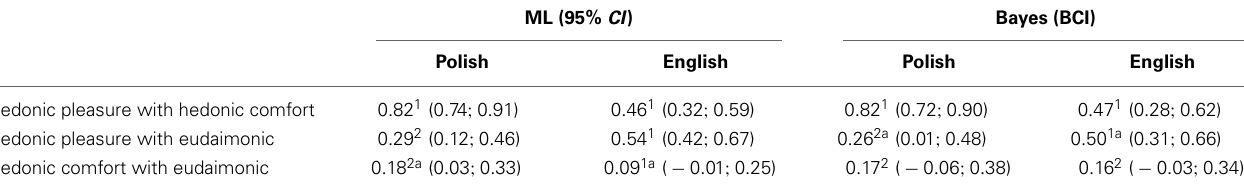
Table 6 | Correlations between latent factors of hedonia and eudaimonia as estimated with ML and Bayes.